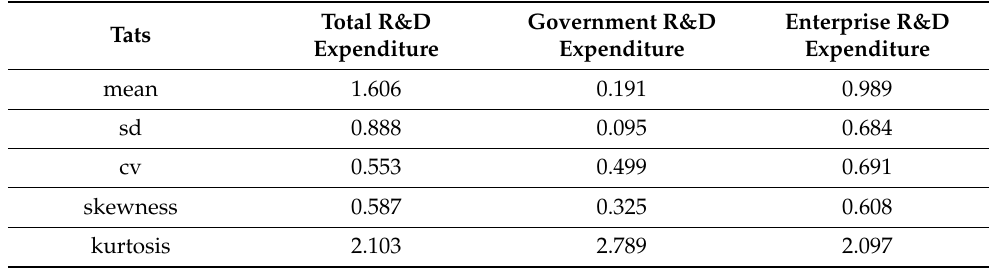
Table 4. Descriptive statistics—independent